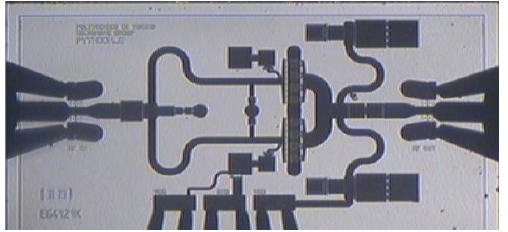
Figure 10. Microscope picture of the 15 GHz (2.3 × 1.3 mm 2 ) MMIC combined